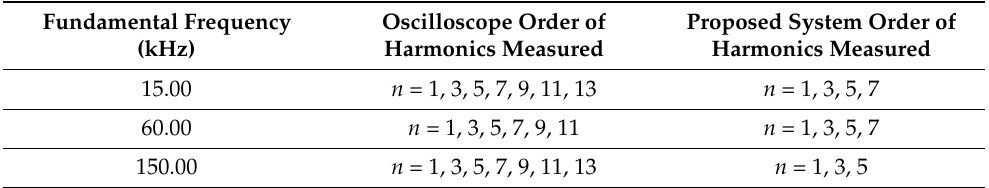
Table 10. The frequency orders that the oscilloscope and the proposed system can recognize according to the fundamental frequency of an applied rectangular signal.